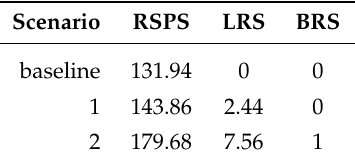
Table 4. Average amount of incoming RDF events on the RSP Service (RSPS), Local Reasoning Service (LRS) and Back-end Reasoning Service (BRS) component for each scenario (averaged over all scenario